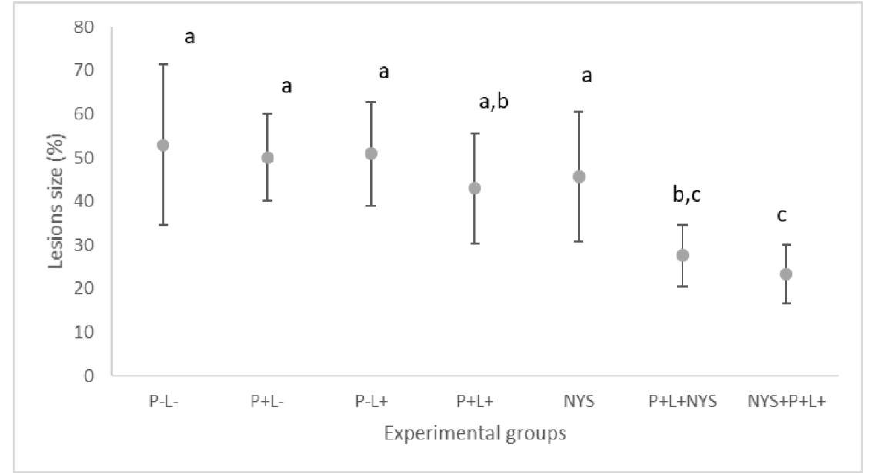
Figure 3. Mean values and standard deviation in percentages (%) of the lesion size (with the size of the patches) on the dorsum of the tongues of all the evaluated animals after 7 days of treatment. The letters a, b and c denote statistical differences between the groups ( p ≤ 0.05).